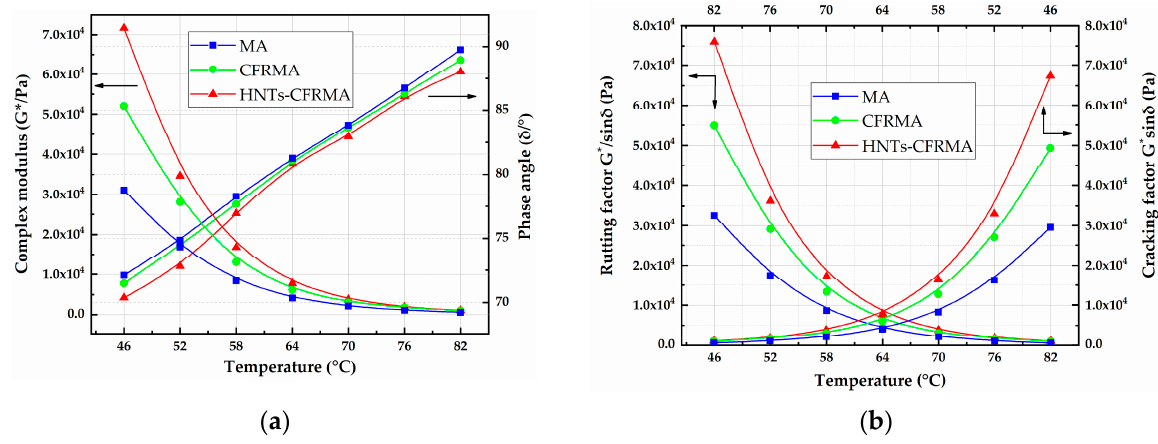
Figure 7. Characterization of flame retardant asphalt DSR-T high temperature performance: ( a ) Complex modulus G ∗ and Phase angle δ ; and ( b ) rutting factor G ∗ / sin δ and cracking factor G ∗ sin δ .